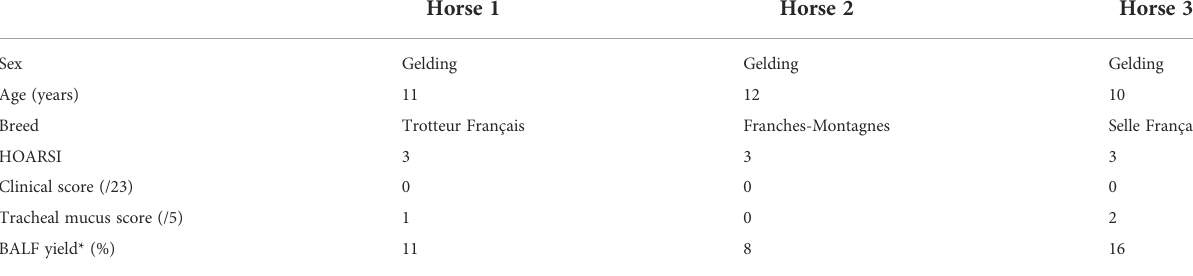
TABLE 1 Characteristics of the study population.